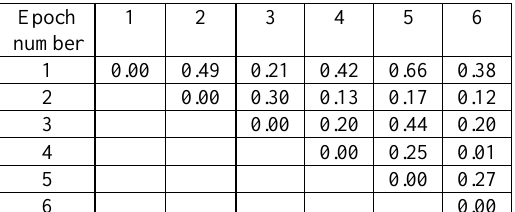
Table 4. RMSE of the 3D points differences (mm)